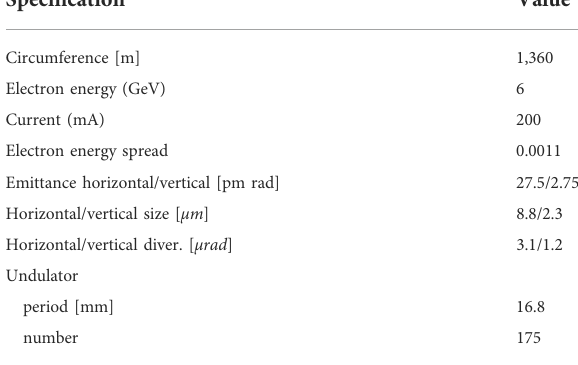
TABLE 1 Parameters for the Storage and undulator.